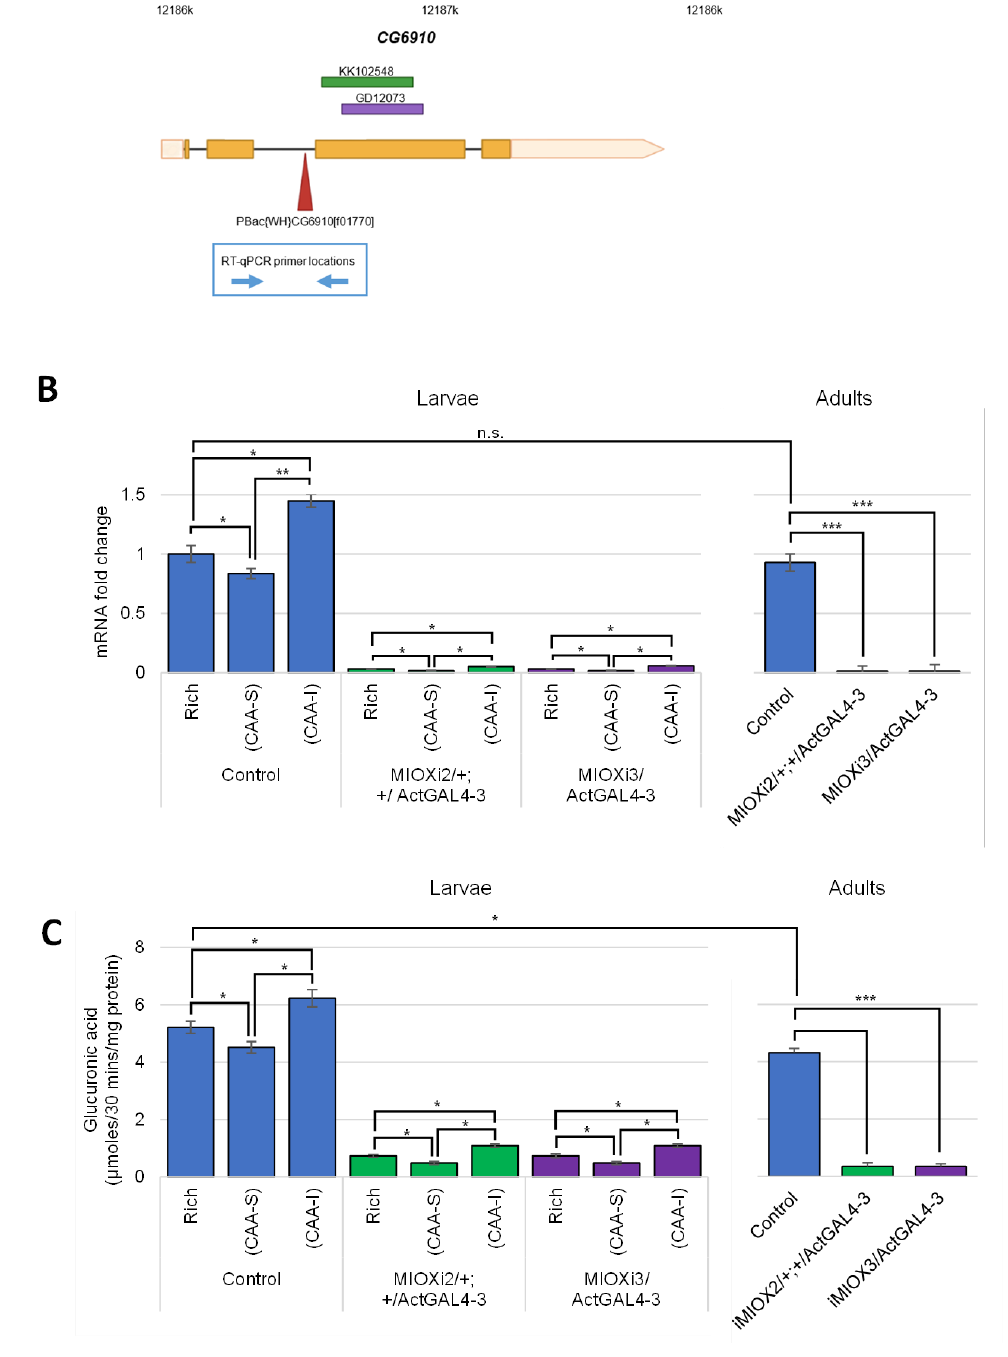
Figure 1. D. melanogaster MIOX (CG6910 ) is regulated in response to dietary myo- inositol. ( A ) The D. melanogaster myo- inositol catabolic gene ( myo- inositol oxygenase) CG6910 , the surrounding genomic region of chromosome 3, and the transcript (isoform B) is displayed. The 5′ and 3′ UTRs are peach, and the exons are orange. The locations of the MIOXi2 (KK102548, green) and MIOXi3 (GD12073, purple) sequences and the ~7.2 kb piggyBac WH-element insertion (red) are also displayed. The primer locations for the qRT-PCR experiments are blue arrows. ( B ) qRT-PCR experiments